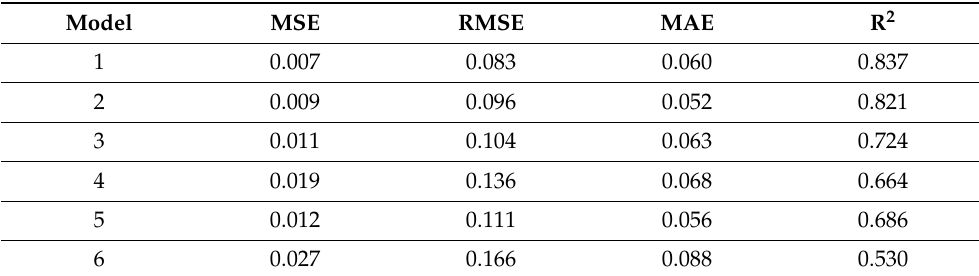
Table 10. Model validation result of set 5 for the sand pack test with SAND_PROD_PER_AREA as the output.